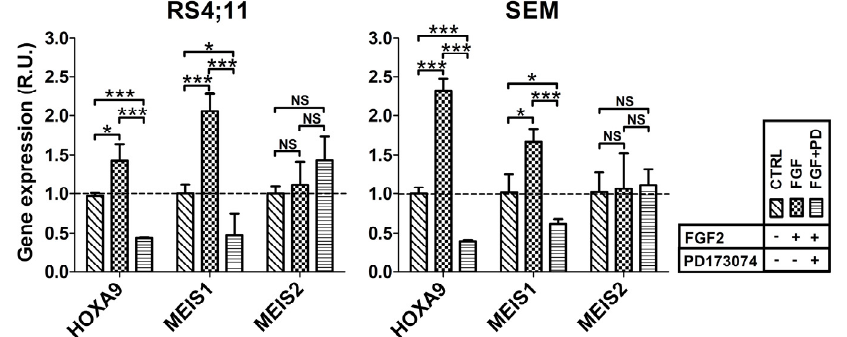
Figure 6. PD173074 inhibitor prevents FGF2-induced transcription of MLL-AF4 target genes. Graphs show transcript levels of MLL-AF4 target genes in leukemia cells, RS4;11 (left) and in SEM (right), stimulated with FGF2 (FGF) or pretreated with PD173074 (FGF + PD). Cells treated with DMSO (vehicle) are used as a control (CTRL); R.U., relative units; p -values are indicated as follows: * p < 0.05, *** p < 0.005.